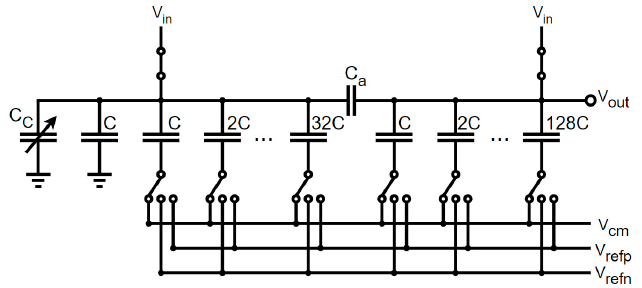
Figure 3. Segmented C-DAC architecture based on V mc switching algorithm.